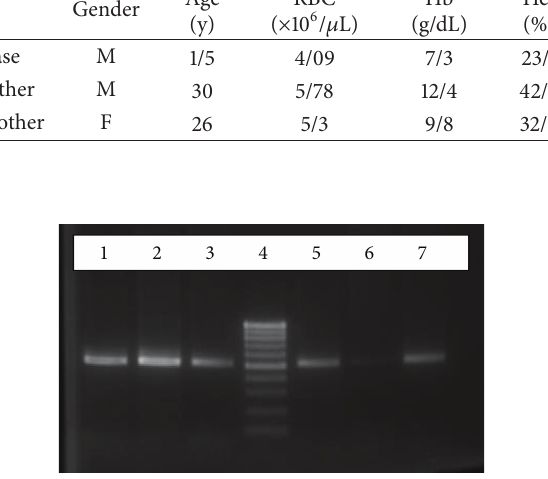
Figure 1: Gel agarose electrophoresis of ARMS-PCR product (522 bp fragment) for the detection of codon 8 (-AA) mutation. Patient sample: lanes 1 and 5, negative (wild type), control: lanes 2 and 6, positive control: lanes 3 and 7,and ladder marker 100bp: lane 4. Lanes 1, 2, and 3 represent PCR products amplified with primers binding normal allele, and lanes 5, 6, and 7 represent PCR products amplified with primers binding mutant